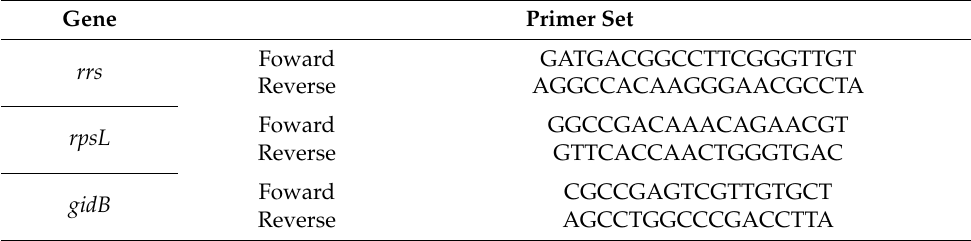
Table 5. Oligonucleotides used in this